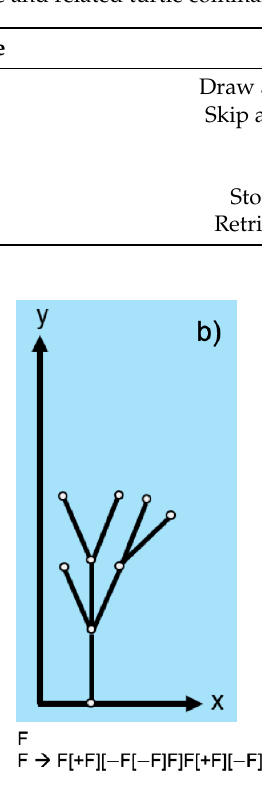
Figure 4. ( a ) L-systems axioms and production rules used in this study based on ( b ) the context-free OL systems defined by Lindenmayer and Prusinkiewicz